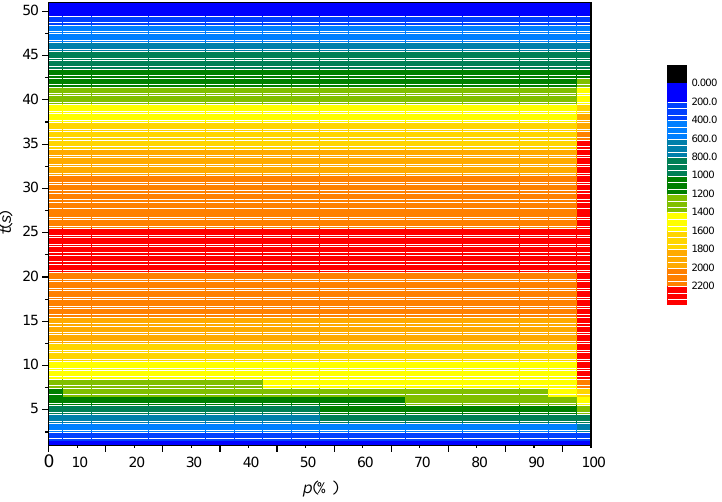
Figure 10. Time-flow variation with different p.